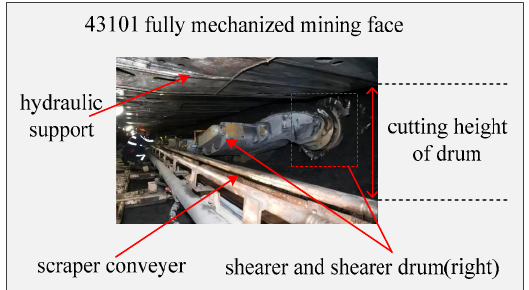
Figure 5. Diagram of 43101 comprehensive mining face.